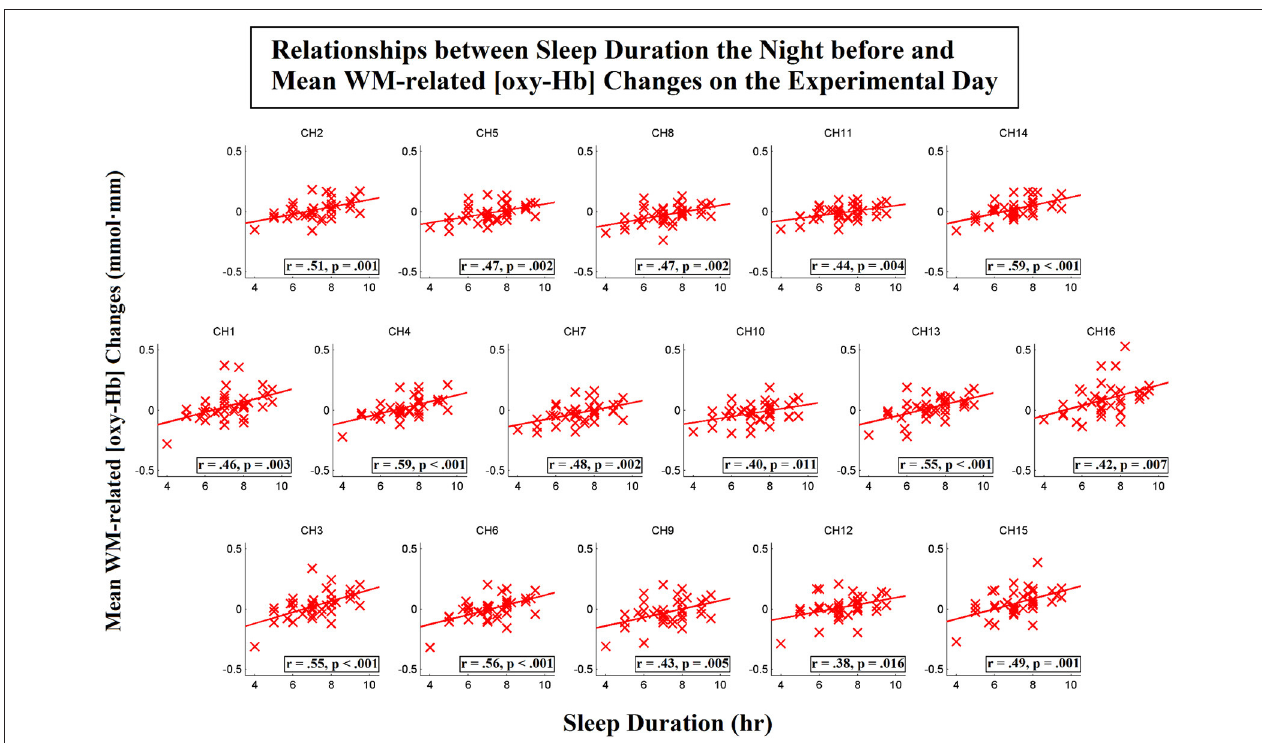
FIGURE 6 | Correlations between sleep duration the night before and mean working-memory-related (WM-related, i.e., 3-back > 0-back) [oxy-Hb] changes on the experimental day. Pearson’s correlation coefficient ( r ) was calculated for each channel, and a linear regression line was fitted to each channel. Channels that exhibited significant correlations are denoted by square borders (ch1-16; FDR-corrected; p s < 0.05;